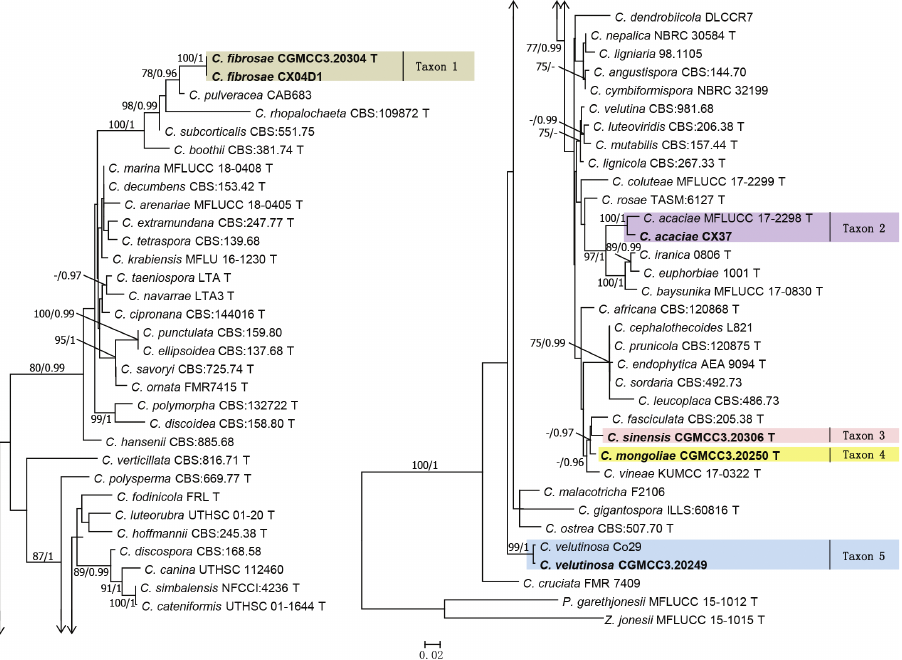
Figure 1. Maximum Likelihood tree constructed using ITS+LSU dataset. Bootstrap support val- ues ≥ 75% and posterior probabilities ≥ 0.95 are indicated above the nodes as ML / PP. The isolates obtained in this study are shown in bold. T = ex-type